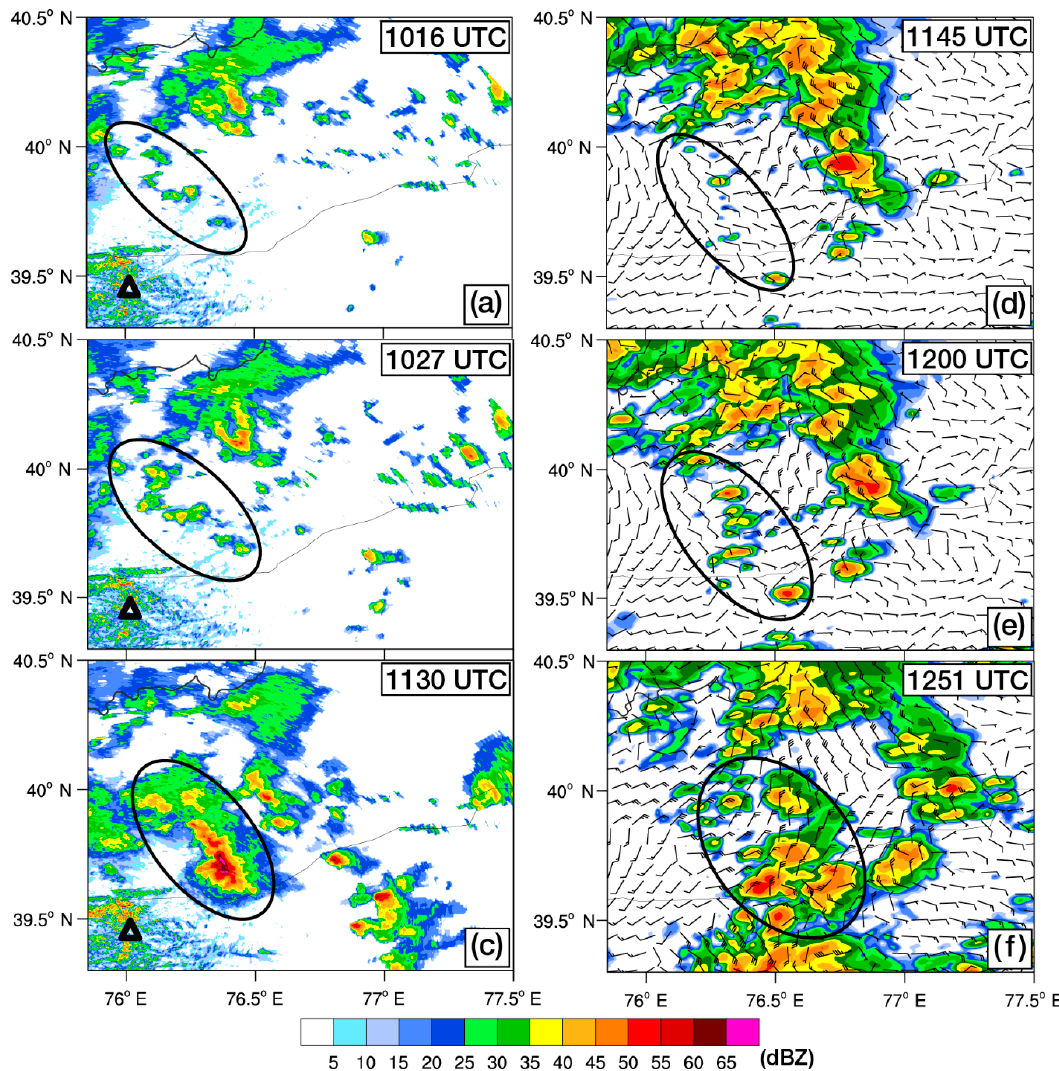
Figure 6. ( a – c ) Observational composite reflectivity (left panels, shading; unit: dBZ) derived from KRS (indicated by black triangle) on 23 June 2015. ( d – f ) Simulated composite reflectivity (right panels, shading; unit: dBZ) and ground-based relative wind field (full and half barbs represent 4 and 2 m·s − 1 , respectively) at the height of 10 m above the ground level on 23 June 2015. The specific time is shown in the upper right corner of each panel.